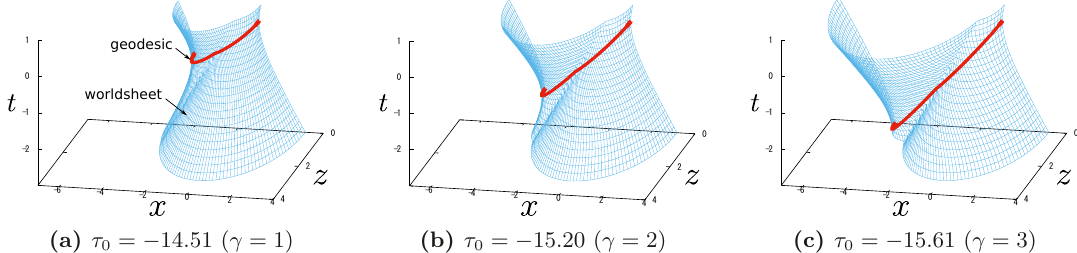
Figure 4. String worldsheets and geodesics between boundaries at τ R = 0 and τ L = 0 for a = 1 and a ′ = a + 10 − 6 . The proper times for the shock surface τ 0 is chosen so that γ = 1 , 2 and 3 in figures (a), (b) and (c),